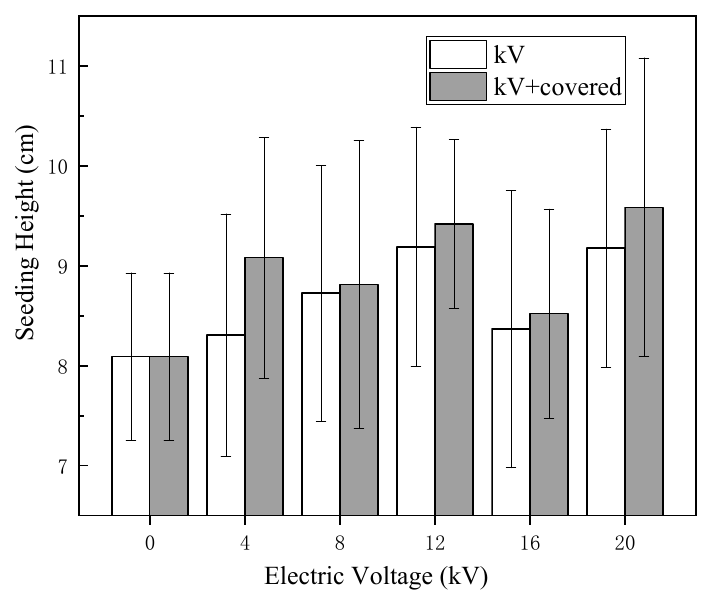
Figure 5. Changes in seedling height of naked oat seedlings after HVEF treatment.